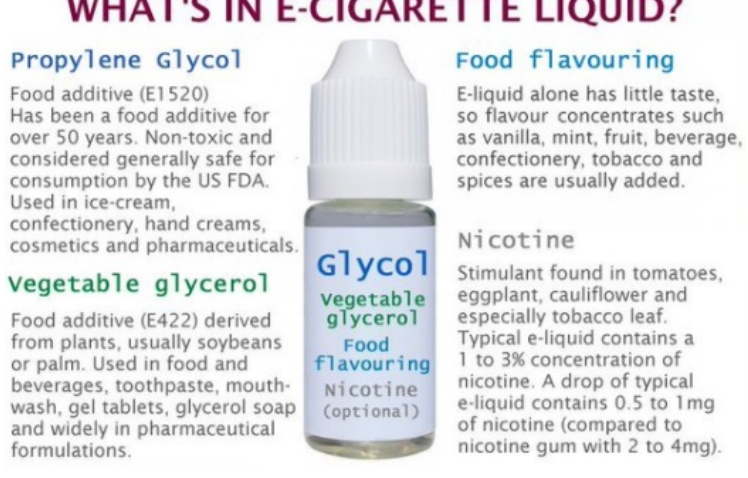
Figure 5. Example of an explanation of e-liquid ingredients within the “health, safety, and product claims” domain.